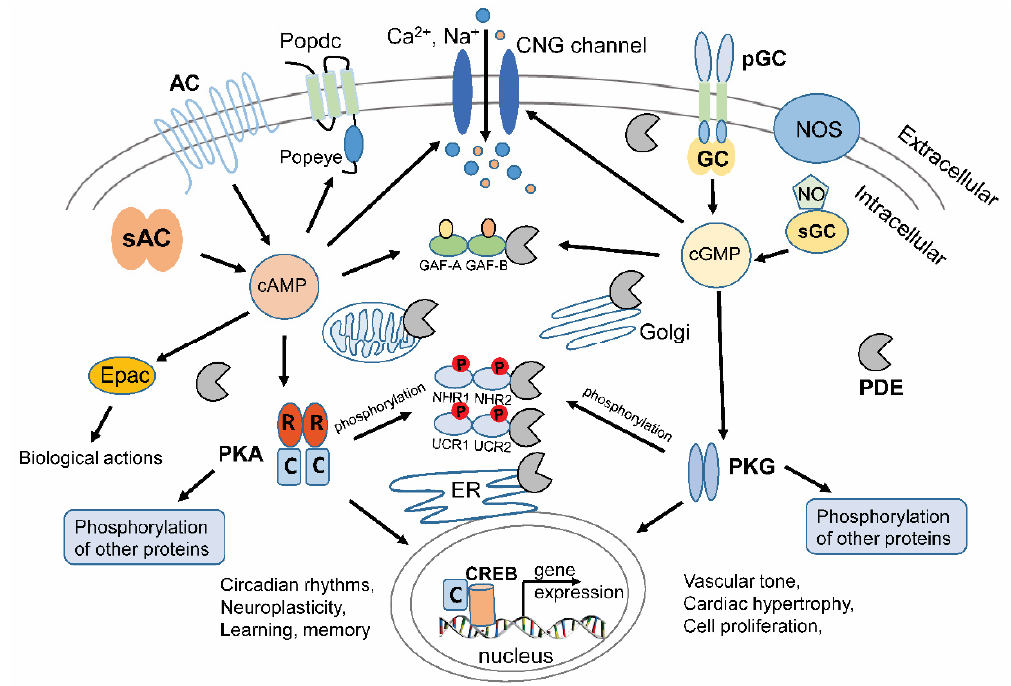
Figure 1. Cyclic nucleotides (cAMP and cGMP) and their typical signal transductions in animal cells. cAMP is produced by membrane-integrated ACs or soluble AC. sGC can be activated by NO produced by NOS and generates cGMP. Membrane-bound GCs respond to external signaling molecules and regulate cGMP production. Main downstream e ff ectors mediated by cAMP and cGMP were depicted. The CNG channels with Ca 2 + / Na + permeability in the plasma membrane can be activated by cAMP or cGMP. As cAMP-specific e ff ectors, Popeye domain containing (Popdc) proteins consist of three transmembrane domains and a cytoplasmic cAMP binding Popeye domain. Popdc plays key roles in maintaining the function of striated muscle cells. In the cytoplasm, various PDEs have GAF domains, GAF-A and GAF-B, in the N -terminal, which can bind either cGMP (for PDE2, 5, 6 and 11) or cAMP (for PDE10), thus regulating C -terminal catalytical activity. PKA and PKG can further regulate downstream protein phosphorylation and CREB transcription factors for certain gene expression. PKA related gene expressions have e ff ects on circadian rhythms, neuroplasticity, learning, and memory, etc. PKG related gene expressions mainly play roles in the cardiovascular system, such as vascular tone, cardiac hypertrophy and cell proliferation etc. PKA and PKG can phosphorylate the NHR domain of PDE3 or UCRdomain of PDE4 and regulate their catalytic activities. Di ff erent PDE isoforms are localized in different microdomains, like ER, mitochondria, Golgi, different cytosolic hotspots, and